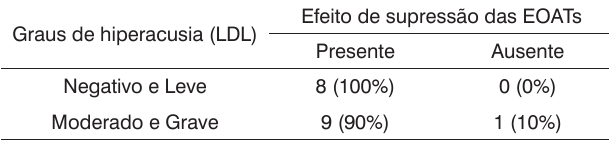
Tabela 7. Graus de hiperacusia segundo o LDL e ocorrência do efeito de supressão das EOATs na orelha